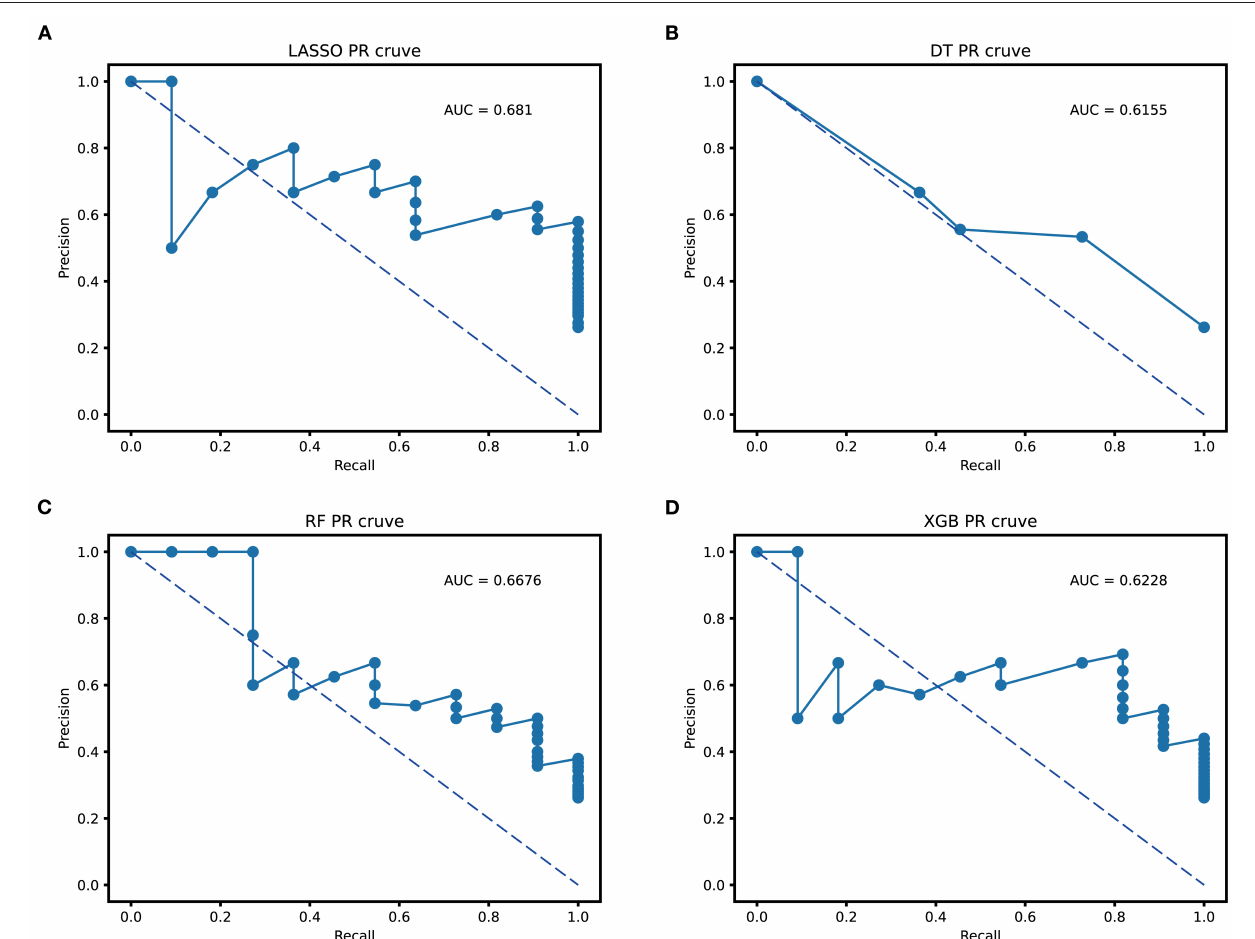
FIGURE 4 | Area under the precision-recall curve (AUC-PR) of all prediction models. (A) the AUC-PR of LASSO; (B) the AUC-PR of DT; (C) the AUC-PR of RF; (D) the AUC-PR of XGBoost. LASSO, least absolute shrinkage and selection operator; DT, decision tree; RF, random forest; XGBoost, extreme gradient boosting.